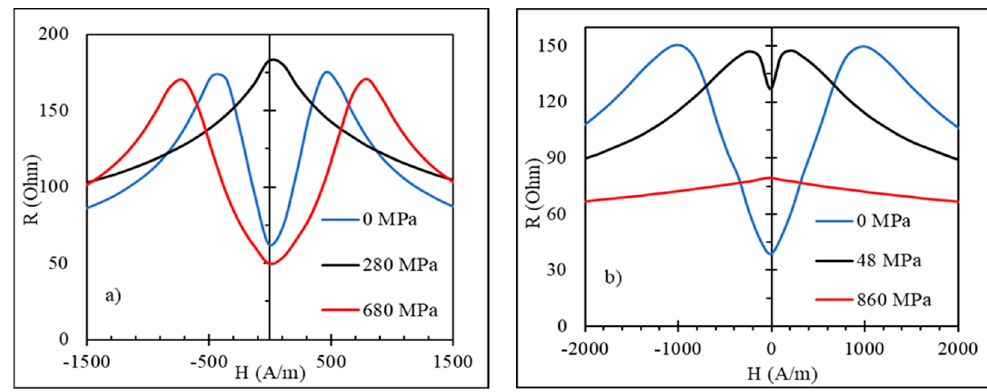
Figure 18. Effect of tensile stress on magnetoimpedance (MI) of glass-coated amorphous Co 71 Fe 5 B 11 Si 10 Cr 3 microwires after current annealing: ( a ) at 50 mA (102 A/mm 2 ) for 60 min and ( b ) at 60 mA (122 A/mm 2 ) for 60 min. Frequency is 50 MHz.